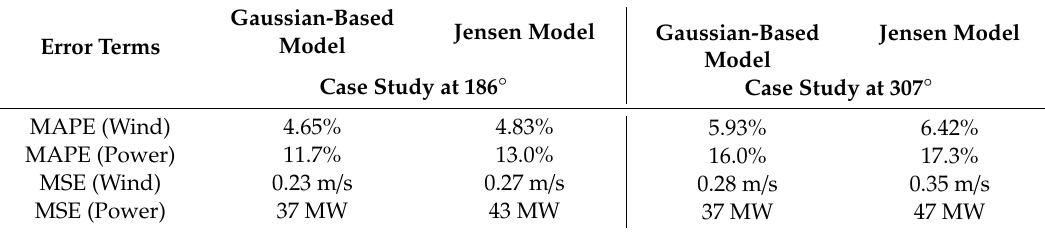
Table 3. 10 minutes average case study prediction errors.